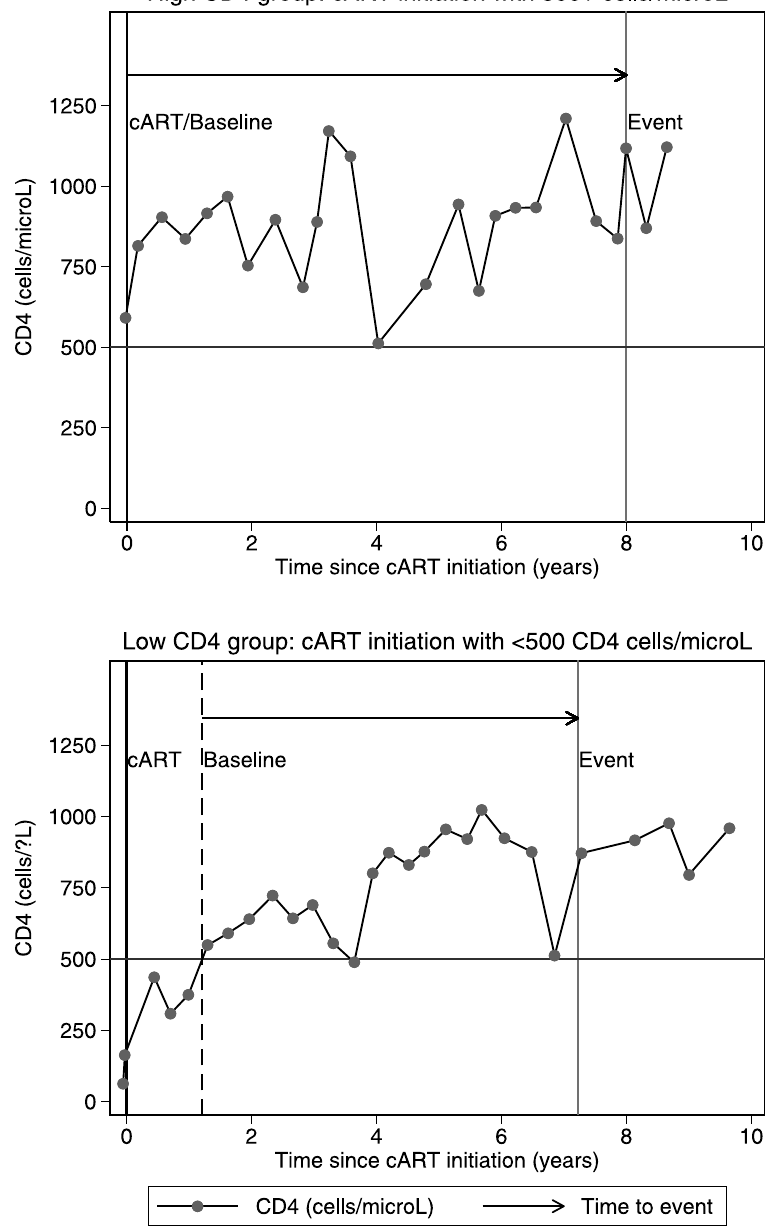
Fig 1. Illustration of the definition of baseline date (as a time origin for the time-to-event analyses) using data from one patient in the “High” and one in the “Low” CD4 group.